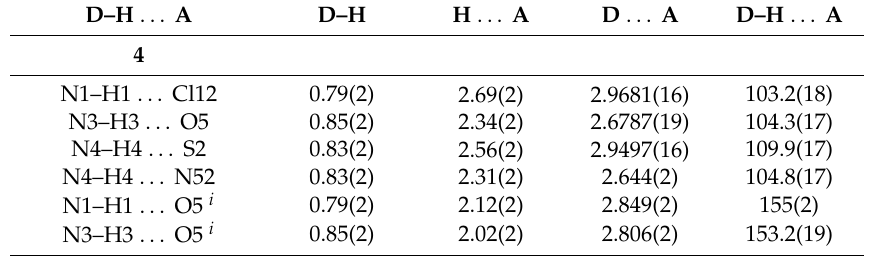
Table 2. Hydrogen-bond geometry (Å, ◦